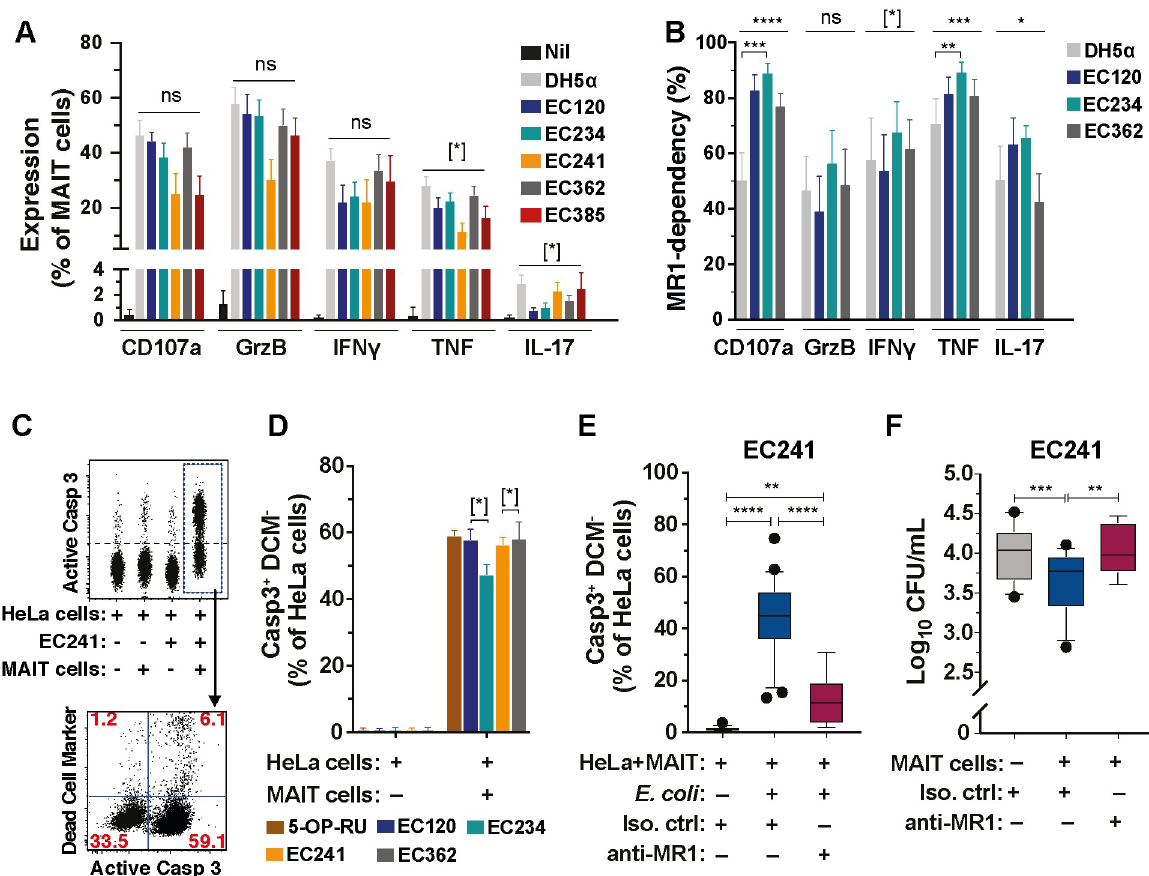
Fig 3. MAIT cells respond to and control CREC. (A) Expression of CD107a, GrzB, IFN γ , TNF, and IL-17A in MAIT cells stimulated for 24 h with E . coli strains DH5 α ( n = 16), EC120S ( n = 7), and the carbapenem-resistant strains EC234 ( n = 16), EC241 ( n = 5), EC362 ( n = 16), and EC385 ( n = 5). Unstimulated, n = 16. (B) MR1-dependency of effector protein and cytokine production by MAIT cells stimulated with indicated strains. MR1-dependency was calculated as previously described [2] ( n = 7). (C) Representative flow cytometry plots of Casp3 activation and apoptosis in HeLa cells alone, HeLa cells infected with EC241, or co-cultured with MAIT cells with or without EC241 for 3 h. (D) Apoptosis of HeLa cells alone or co-cultured with MAIT cells for 3 h in the presence of 5-OP-RU, EC120S, EC234, EC241, or EC362 ( n = 5). (E, F) Casp3 activation (E) and bacterial loads (F) in HeLa cells infected with EC241 co-cultured with MAIT cells in the presence of anti-MR1 antibody or isotype control ( n = 5–8 for EC241-infected HeLa cells+anti-MR1 mAb, n = 13–25 others). Data presented as bar graphs with error bars represent the mean and standard error. Box and whisker plots show median, the 10th to 90th percentile, and the interquartile range. Statistical significance was determined using the Kruskal-Wallis ANOVA (A) or the Friedman test (B, D) followed by Dunn’s multiple comparison test, or mixed-effects analysis followed by Dunnett’s multiple comparison test (E, F). ���� p < 0.0001, ��� p < 0.001, �� p < 0.01, � p < 0.05, [ � ] p < 0.1. The underlying data of this figure can be found in S1 Data. Casp, caspase; CFU, colony-forming units; CREC, carbapenem-resistant E . coli ; Ctrl, control; DCM, dead cell marker; FCS-A, forward scatter area; Grz, Granzyme; IFN γ , interferon γ ; IL-17A, interleukin-17A; mAb, monoclonal antibody; MAIT, Mucosa-associated invariant T; MR1, MHC-Ib-related protein; TNF, tumor necrosis factor; 5-OP-RU, 5-(2-oxopropylideneamino)-6-D-ribitylaminouracil.